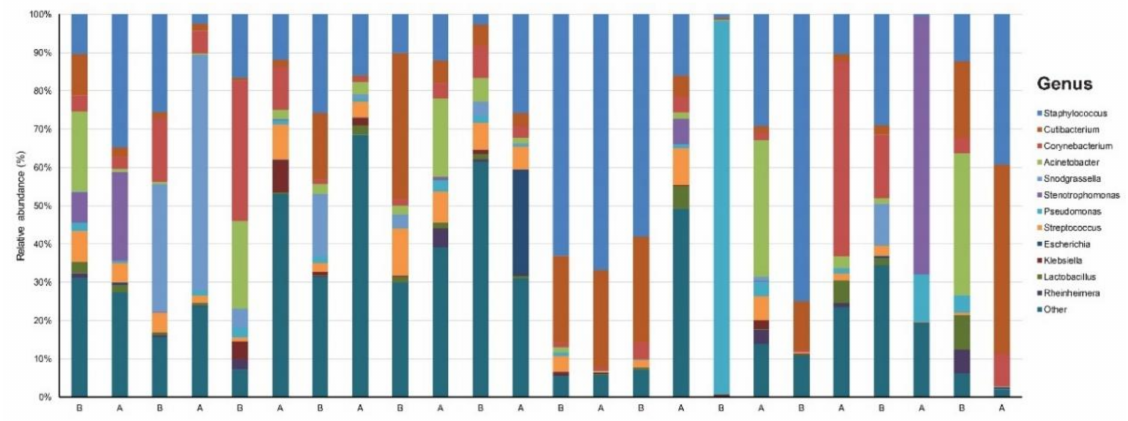
Figure 1. Taxonomy plot of the microbial communities of rosacea patients before (B) and after (A) six weeks of